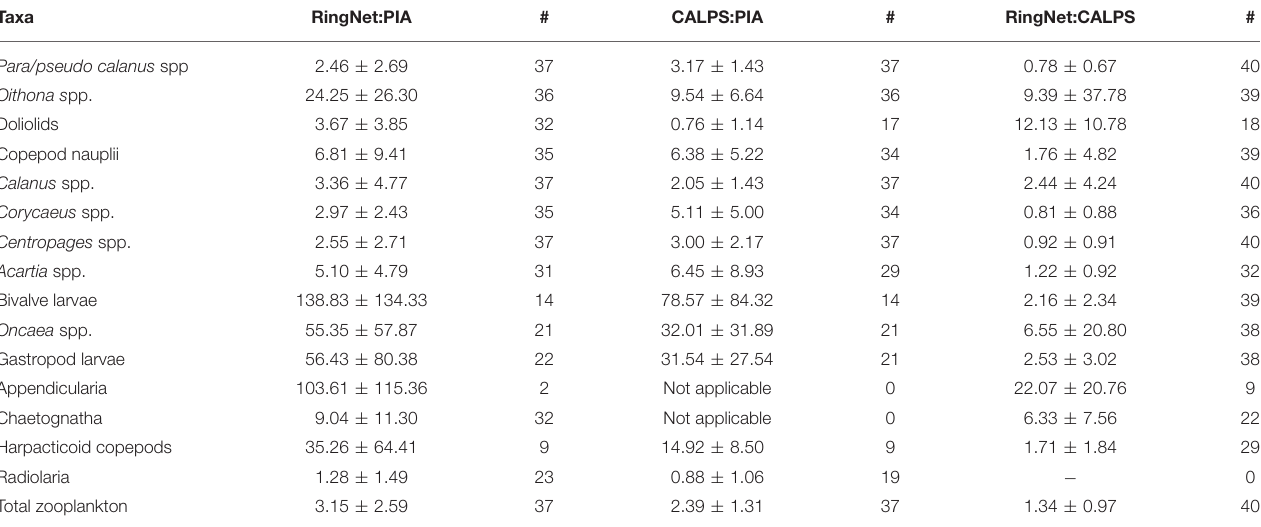
TABLE 2 | Comparison of the abundances of the main zooplankton taxa collected from the PIA, CALPS, and ring net devices. Taxa RingNet:PIA # CALPS:PIA # RingNet:CALPS # Para/pseudo calanus spp